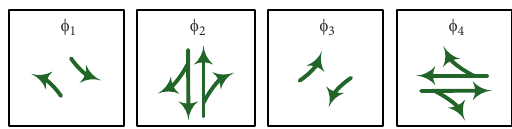
Figure 1. Approach-based phasing scheme Figure 2. Protected movement-based signal phasing